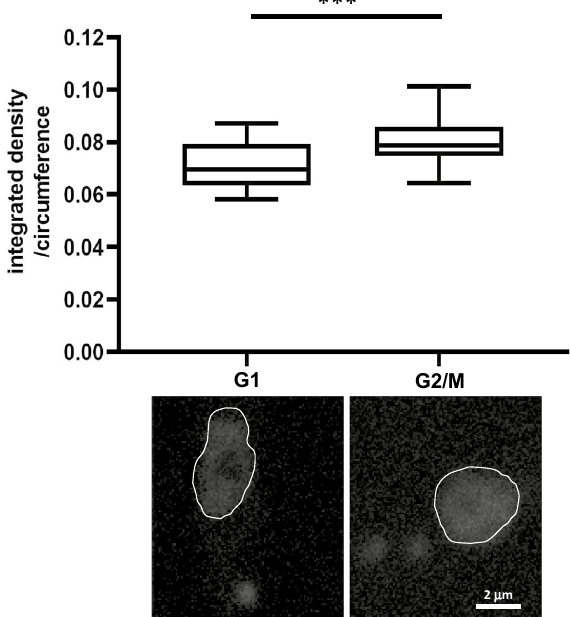
Figure 3. Analysis of chromosome compaction in T. brucei . 1 × 10 7 cells were fixed, stained with DAPI, and analyzed via two-photon microscopy. The cell cycle stage of the cells was determined by the number of kinetoplasts and their localization with respect to the nucleus. 25 nuclei were analyzed from each cell cycle phase. *** p < 0.0003.